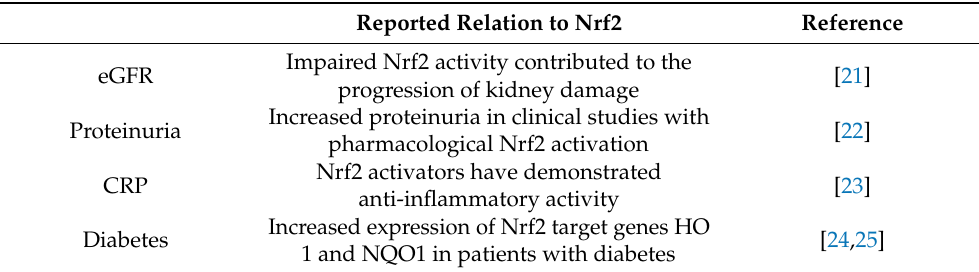
Table 2. Basis for the selection of clinical parameters for the relation analyses with Nrf2 protein concentration in our study.